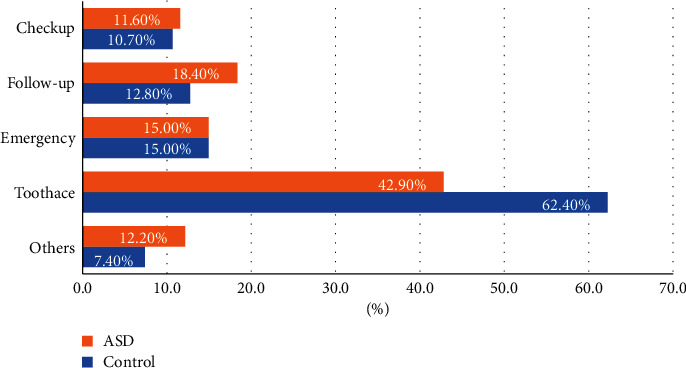
Reasons for last visit to dental service for ASD and control.